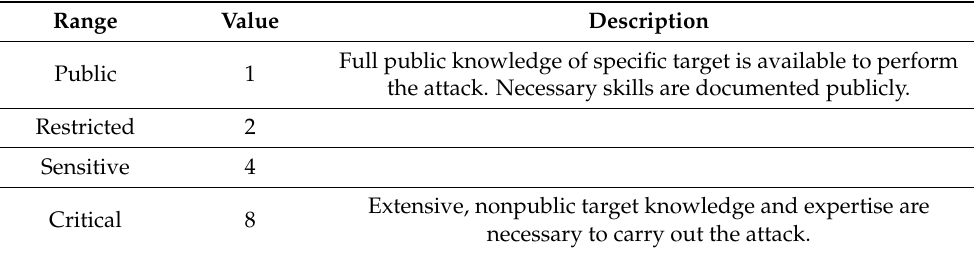
Table 9. Attack potential factor: expertise/skills.